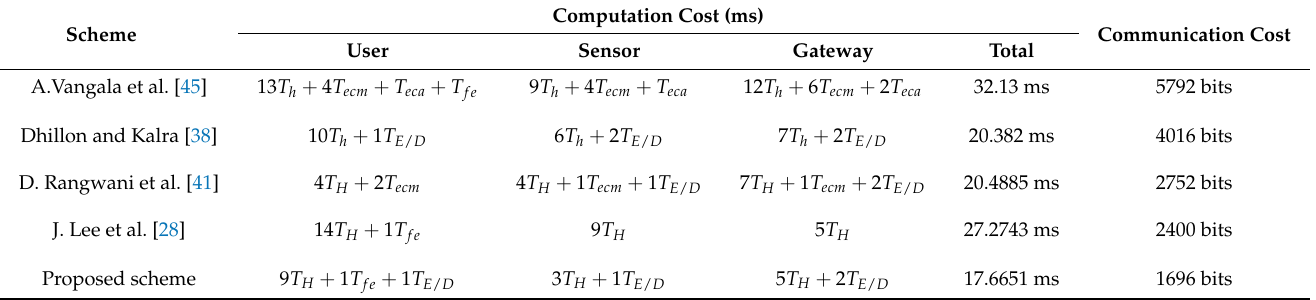
Table 4. Comparison of the computation and communication costs of